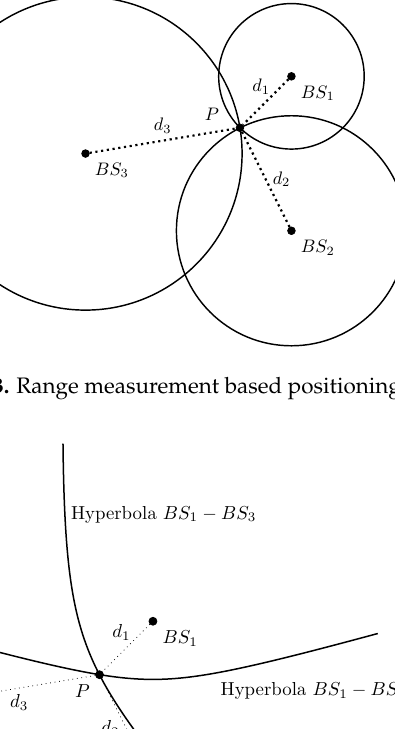
Range measurement based 2D Figure 3. positioning with at least 3 BS.